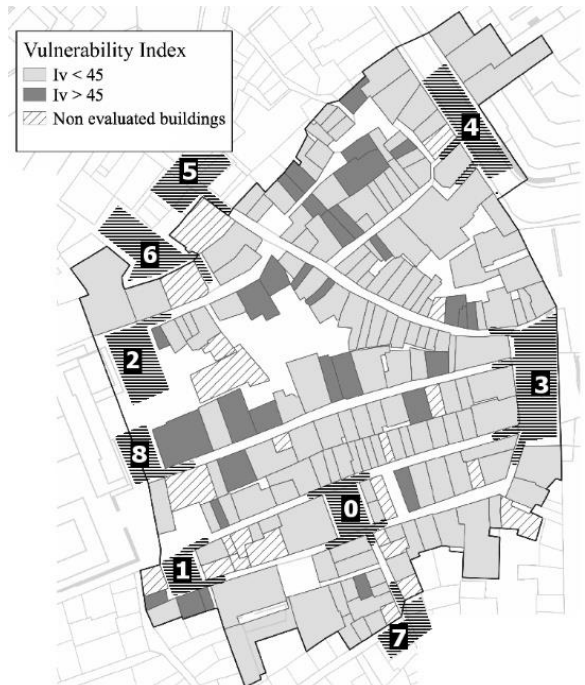
Figure 2. Urban layout involved in the simulation, by outlining the building vulnerability and the position of assembly areas and related main accesses (dashed areas) defined in the emergency plan of the SCENARIO